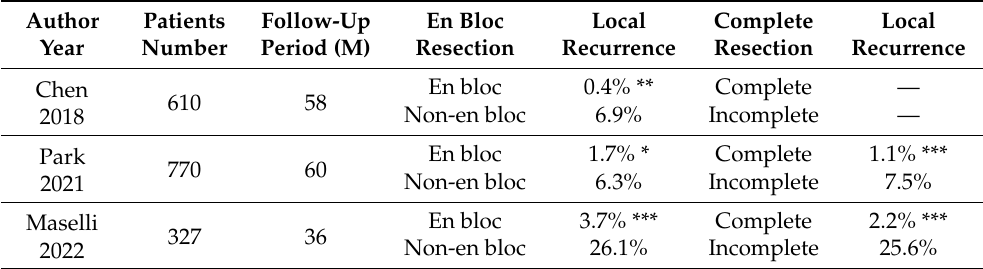
Table 3. Resection status and recurrence rates.